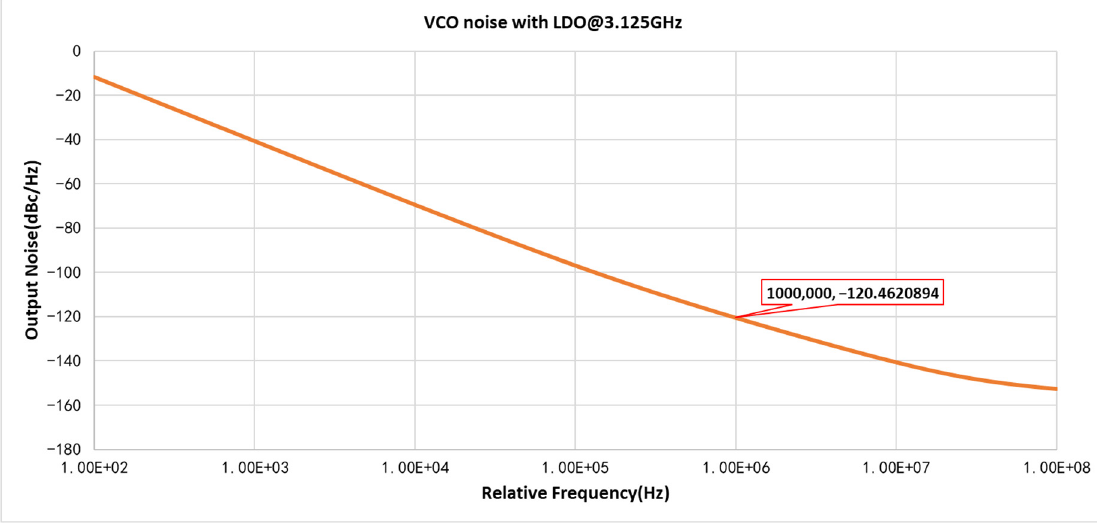
Figure 7. LC VCO output phase noise post-simulation results.